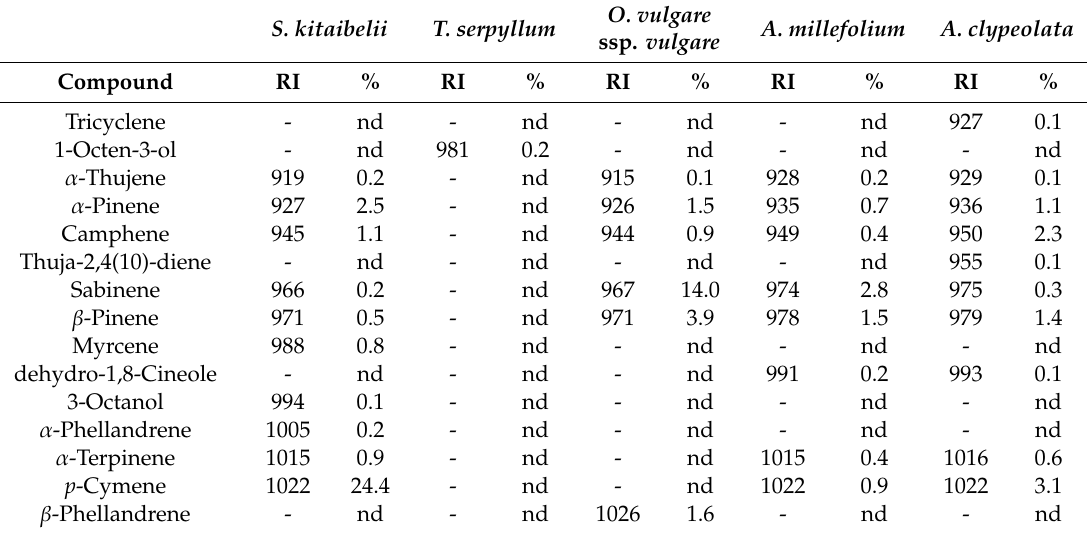
Table 1. Chemical composition of investigated essential oils